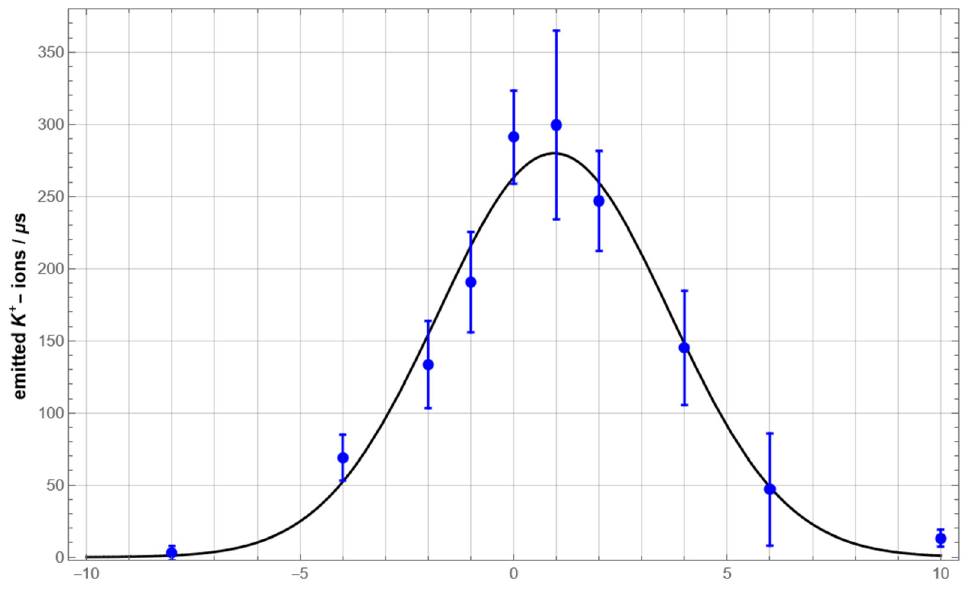
Figure 5. The K + ion current as a function of length of the selectivity filter. Each blue dot marks the mean value obtained from 8 molecular dynamics simulations of the selectivity filter, each enduring 10 µs. The error bars indicate the related standard deviations. The black curve demonstrates a Gaussian fit to these data (Fit function: I ( x ) = I 0 e − ( x − x 0 ) 2 /2 w 2 , with fit parameters I 0 = 280.0 ions/ µ s, x 0 = 0.949 percent, w = 2.70